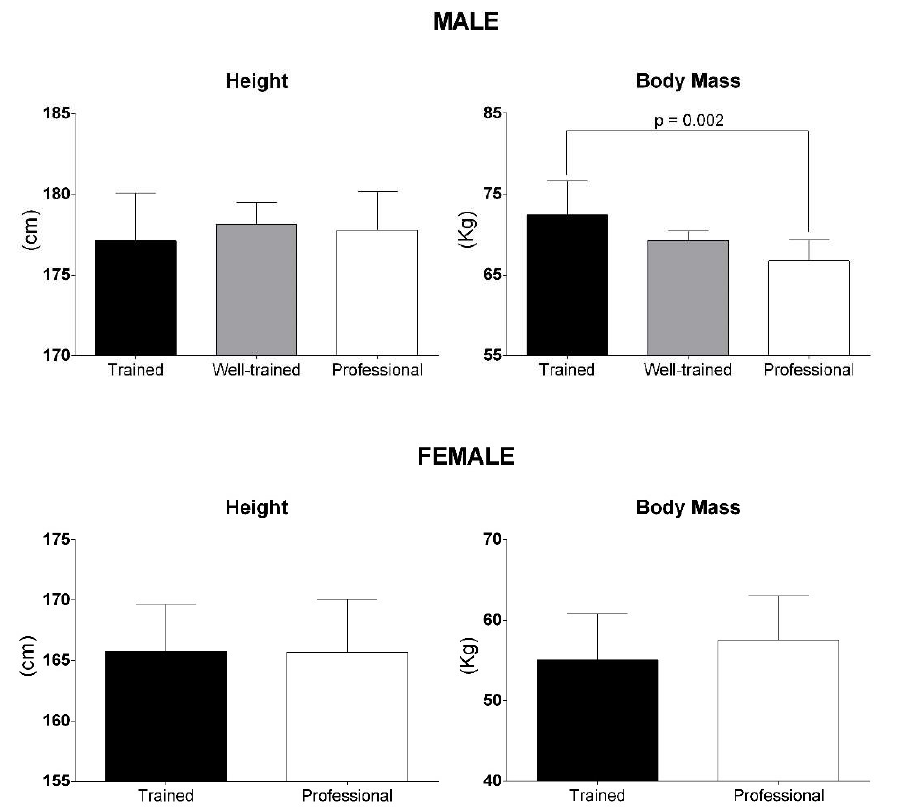
Figure 5. Anthropometric profile of the XC-MTB cyclists according to performance level and sex. Data are mean ± SD.